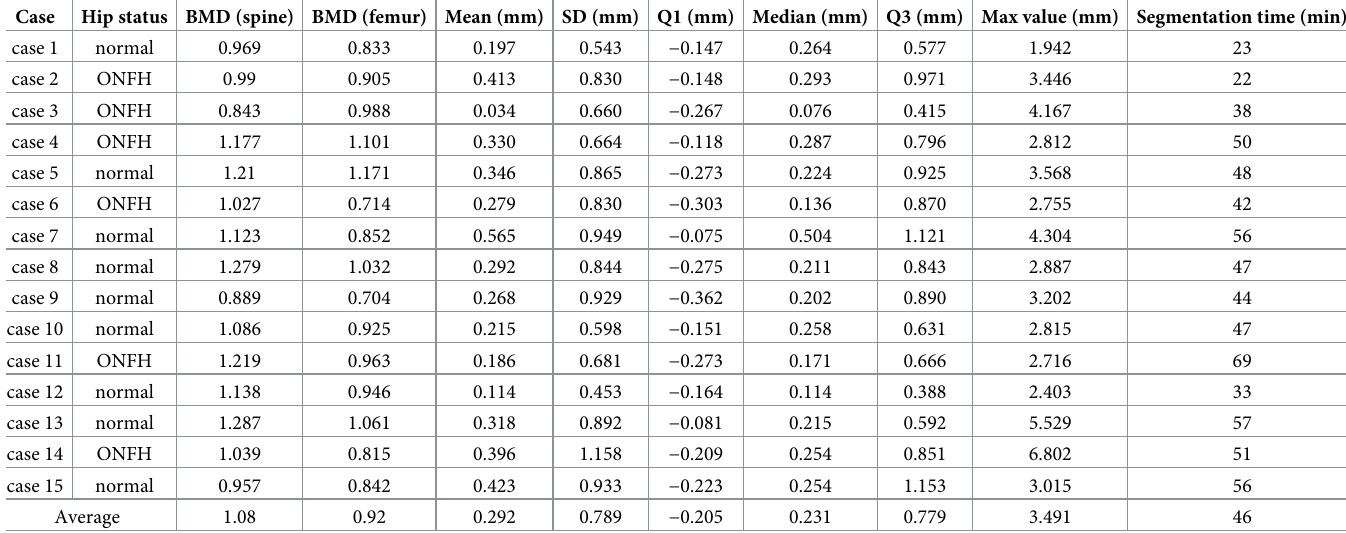
Table 2. Image registration error for the total hip between 3D-CT and 3D-MRI using the water excitation method. Case